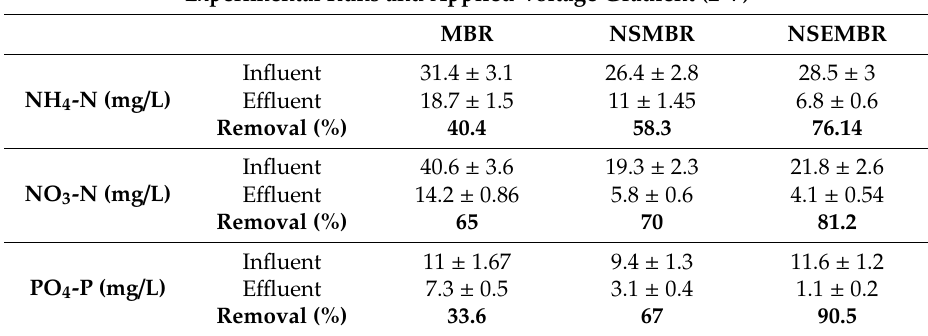
Table 4. Nutrient removals in membrane bioreactor (MBR), nanotubes coated sponge–MBR (NSMBR), and electro-membrane bioreactor (ENSMBR).